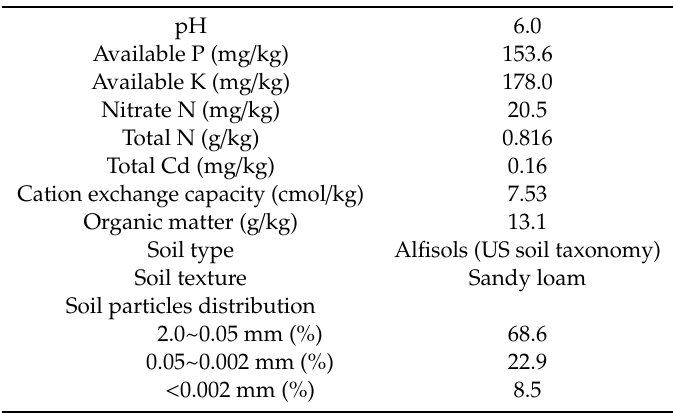
Table 1. Physical and chemical properties of the test